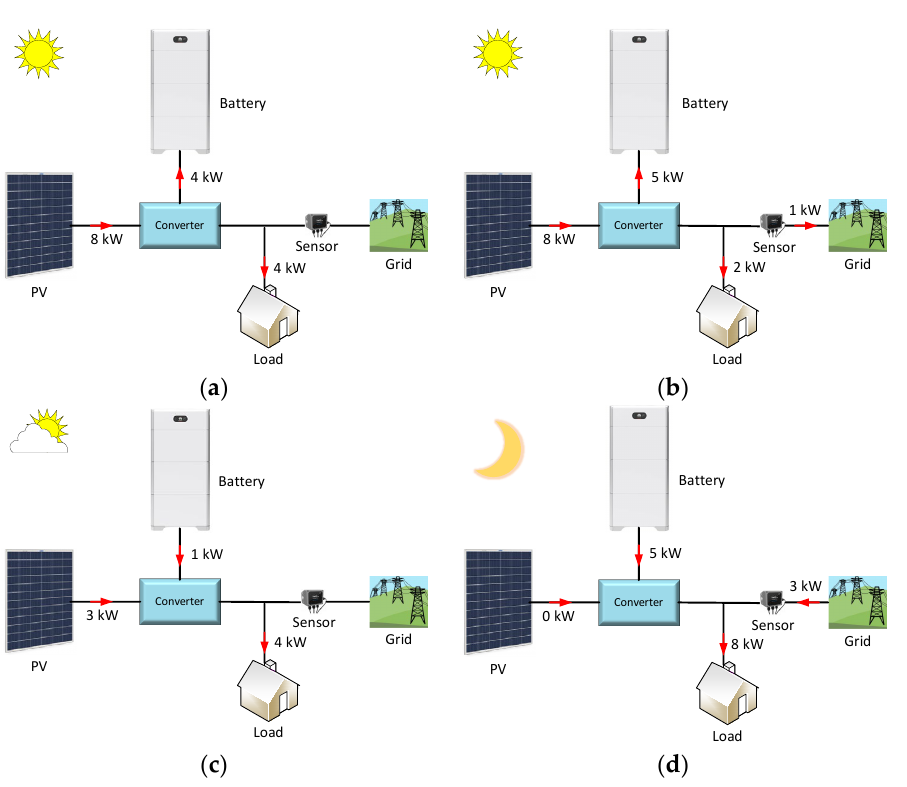
Figure 9. Examples of the maximum self-consumption strategy.